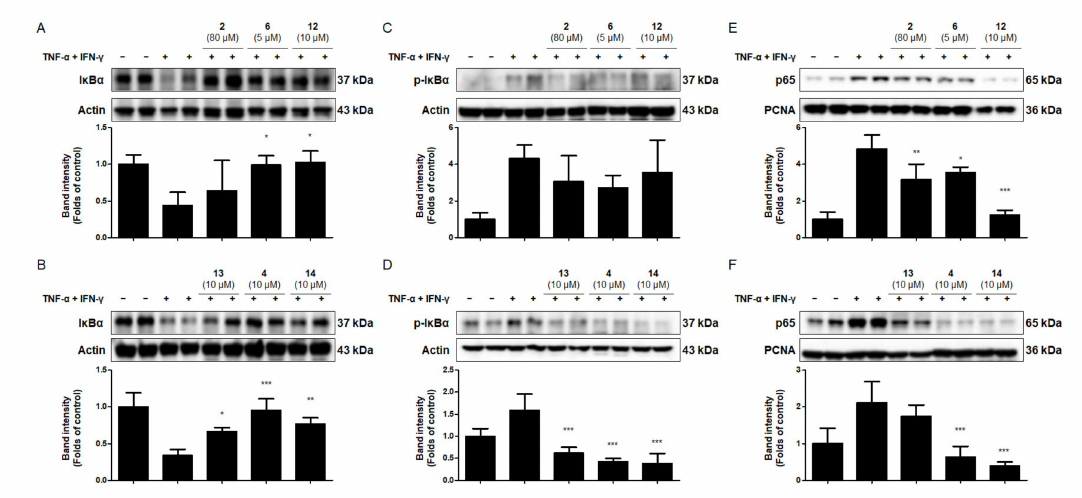
Figure 5. Effects of the six compounds from C. tricuspidata on the degradation of I κ B- α ( A , B ), the phosphorylation of I κ B α ( C , D ), and the translocation of NF- κ B p65 to the nucleus ( E , F ) in HaCaT cells. Cells were pretreated with the six compounds from C. tricuspidata at the indicated concentrations for 3 h and stimulated with TNF- α + IFN- γ (20 ng/mL) for 10 min. I κ B α , p-I κ B α , and NF- κ B p65 were analyzed using Western blotting, as described in the Materials and Methods section. Representative blots from four independent experiments are presented. The immunoblots were quantified using ImageJ software. The band intensity was normalized to that of actin or anti-proliferating cell nuclear antigen (PCNA). * p < 0.05, ** p < 0.01, *** p < 0.001 compared with TNF- α + IFN- γ